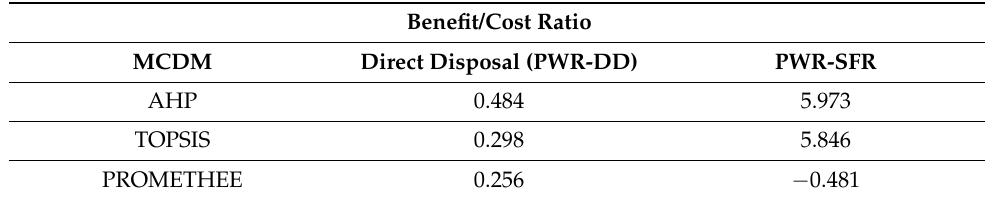
Table 8. Calculation results of benefit and cost